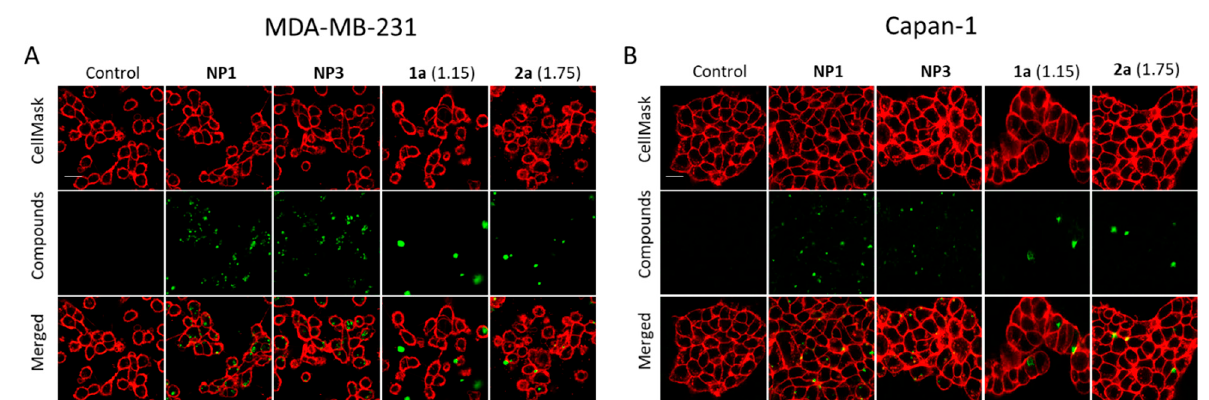
Figure 7. 2PEF imaging of ( A ) MDA-MB-231 breast cancer cells and ( B ) Capan-1 pancreas cancer cells, incubated for 20 h with NP1 or NP3 (25 µg·mL − 1 ) and with analogous TEG-ylated 1a and 2a at the same porphyrin concentrations. Porphyrins were excited with a Chameleon femtosecond laser (in green, λ ex = 790 nm,) and cell membranes were stained with CellMask Orange (in red, λ ex = 561 nm). Scale bar: 10 µm.